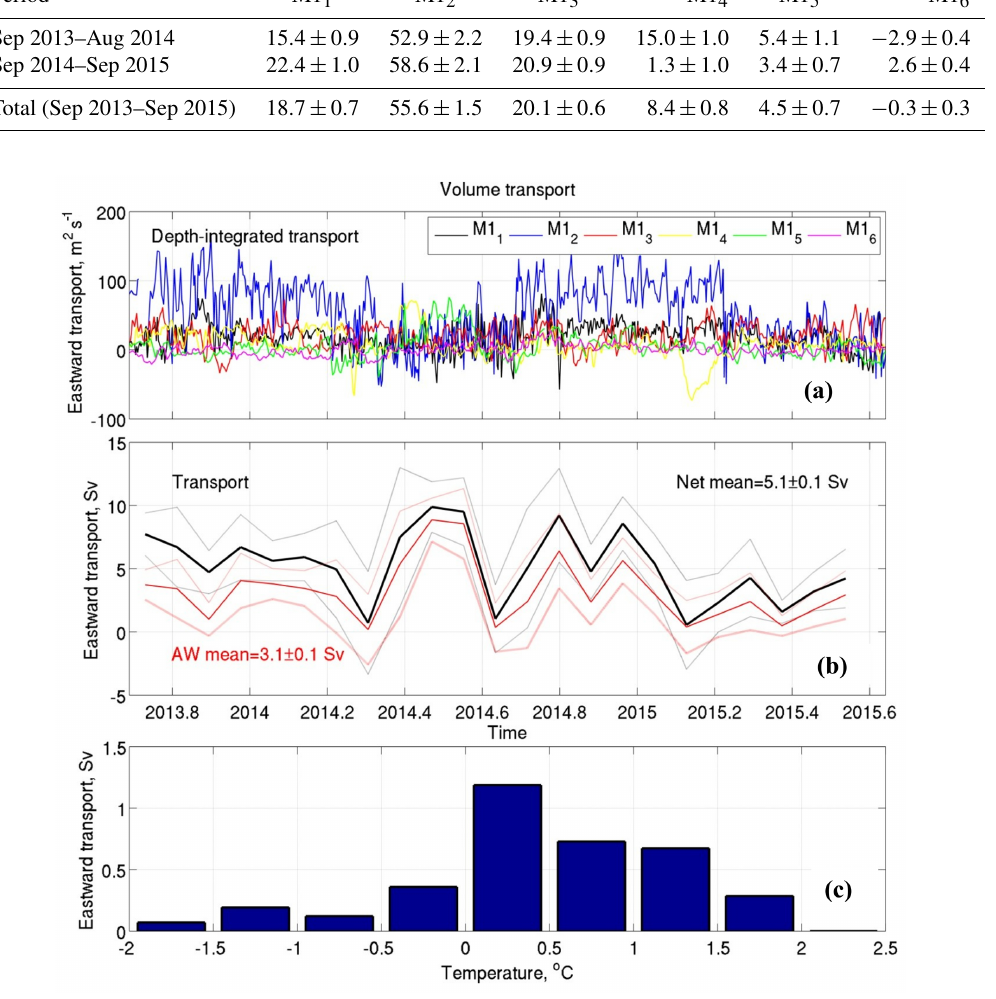
Figure 8. (a) Depth-integrated volume transports (m 2 s − 1 ) in the layer spanned by 2013–2015 velocity observations at six moorings at the Laptev Sea slope; (b) monthly net volume transport in the upper 780m layer (black) and in the AW layer (red) across the 125 ◦ E section. Dotted lines show 1 standard deviation intervals. (c) Distribution of eastward volume transports averaged over 0.5 ◦ C temperature